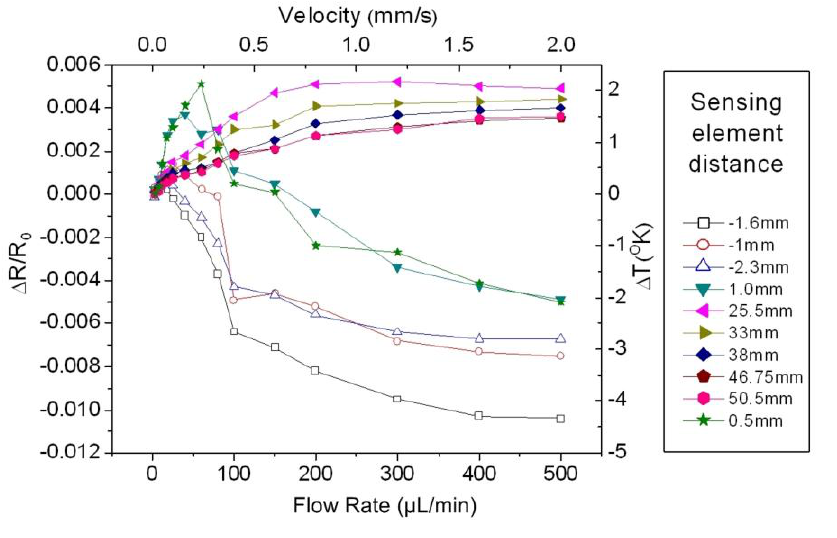
Figure 12. The normalized resistance change of the sensing elements as a function of the flow rate, for water as the test liquid. The distance of each sensing element to the heater is depicted, with the negative values corresponding to the upstream sensing elements. The tube crossectional area is 4.2 mm 2